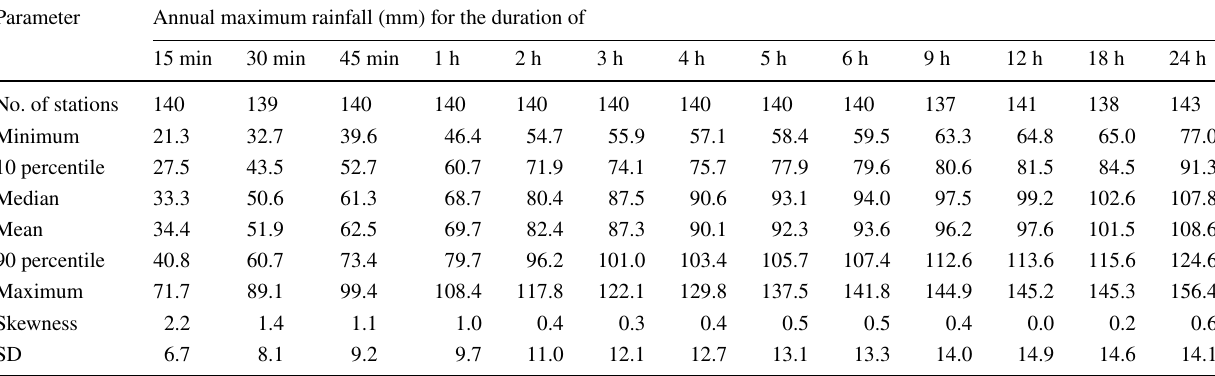
Table 1 Statistical summary of mean annual rainfall values in Klang Valley Parameter Annual maximum rainfall (mm) for the duration of